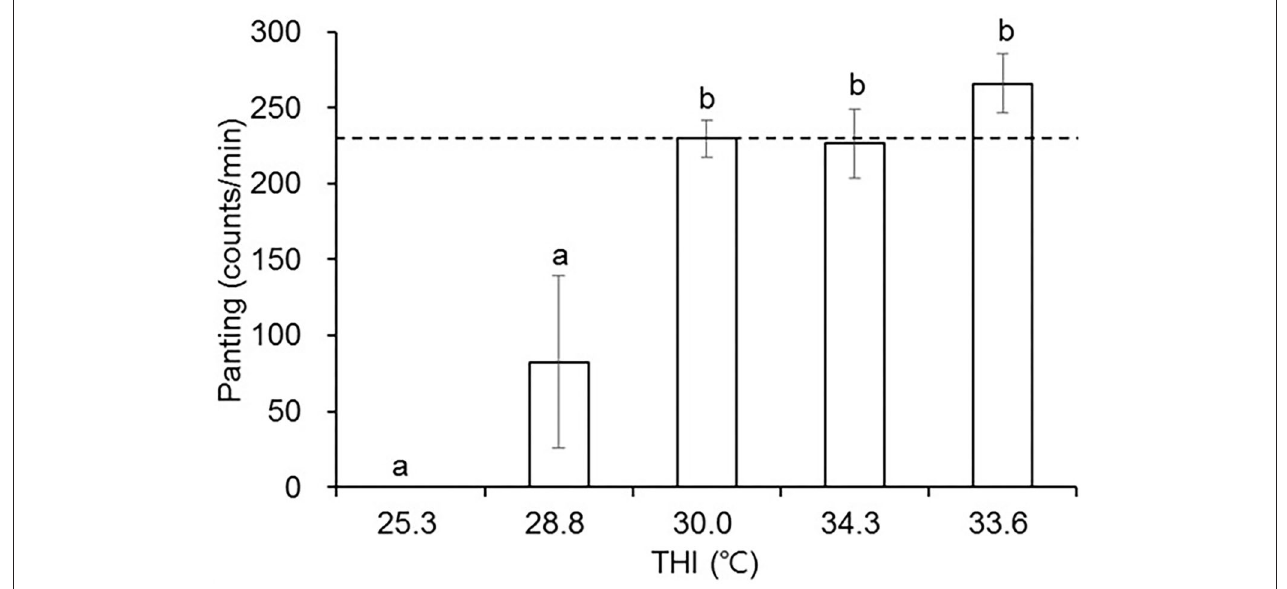
FIGURE 4 | The effects of temperature-humidity index (THI) ( ◦ C) on panting (counts/min) in laying hens. Five groups ( n = 12 each) of hens were exposed to one of the following five-THI conditions for different time periods (0, 40, 100, 160, or 280min), and hens’ behaviors were recorded and analyzed for panting frequency which was counted at the time points specified (min) ( n = 5 each group). Temperature-humidity index (THI) ( ◦ C), dry-bulb temperature ( ◦ C), web-bulb temperature ( ◦ C), and relative humidity (%) were 25.3, 28.0, 55.0, and 21.2 for 0min; 28.8, 32.1, 50.0, and 23.7 for 40min; 30.0, 33.1, 54.0, and 25.4 for 100min; 34.3, 38.4, 46.0, and 28.0 for 160min; 33.6, 38.3, 40.0, and 26.5 for 280min, respectively. The dot line indicates THI of 30 ◦ C. a,b Means with different superscripts differ significantly in panting frequency at p < 0.05.